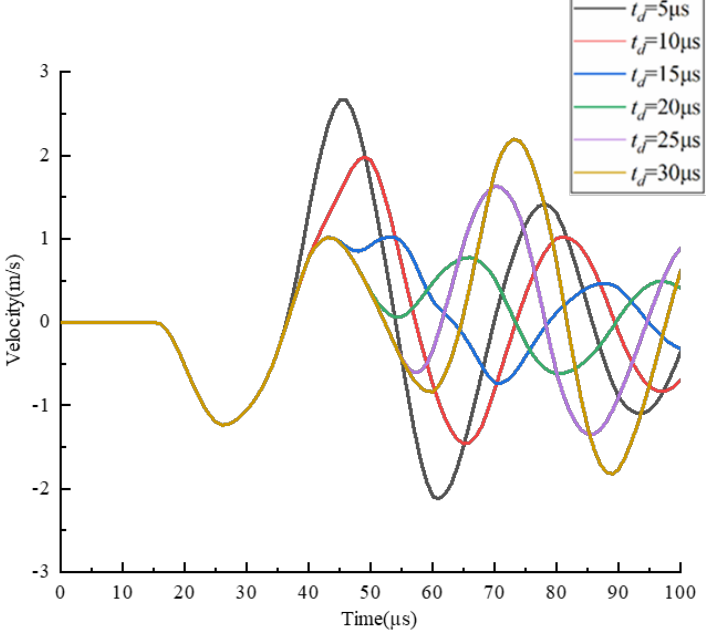
Figure 11. Effect of t d on the pressure at the nozzle.